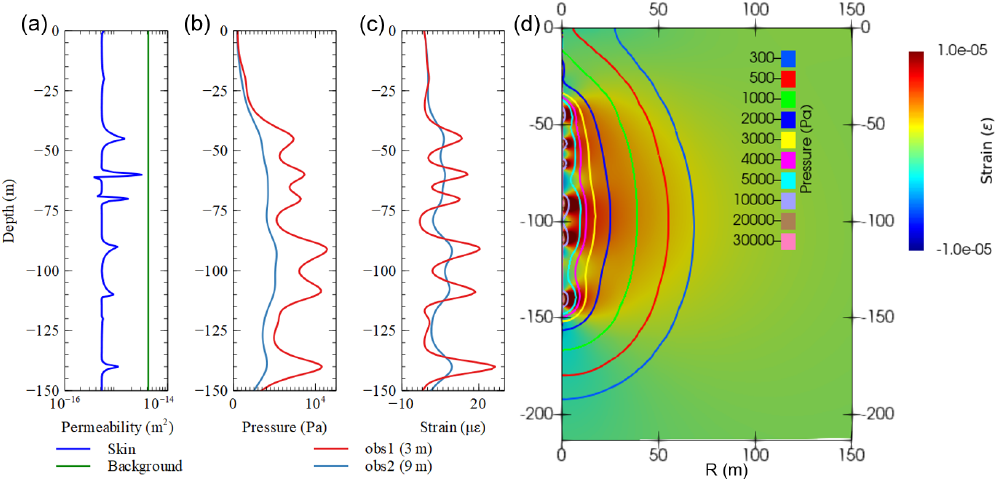
Figure 9. Assumed permeability structure of the skin formed by mud filter cakes (a) ; profiles of the modeled pore pressure (b) and strain (c) changes at the distance of wells obs1 and obs2; and spatial image of strain with contour of pressure changes (d) on day 10.